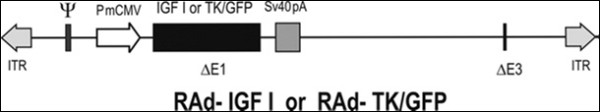
Schematic representation of the construction of the RAd-IGF-I and RAd-TK/GFP adenoviral vectors. PmCMV, mouse cytomegalovirus promoter; IGF-I, cDNA for rat IGF-1; TK/GFP, hybrid DNA sequence encoding the fusion protein TK/GFP; ITR, inverted terminal repeat; ΔE1 and ΔE3, deletions in the AD5 genome; SV40, simian virus 40 polyadenylation signal; Ψ, packaging signal.